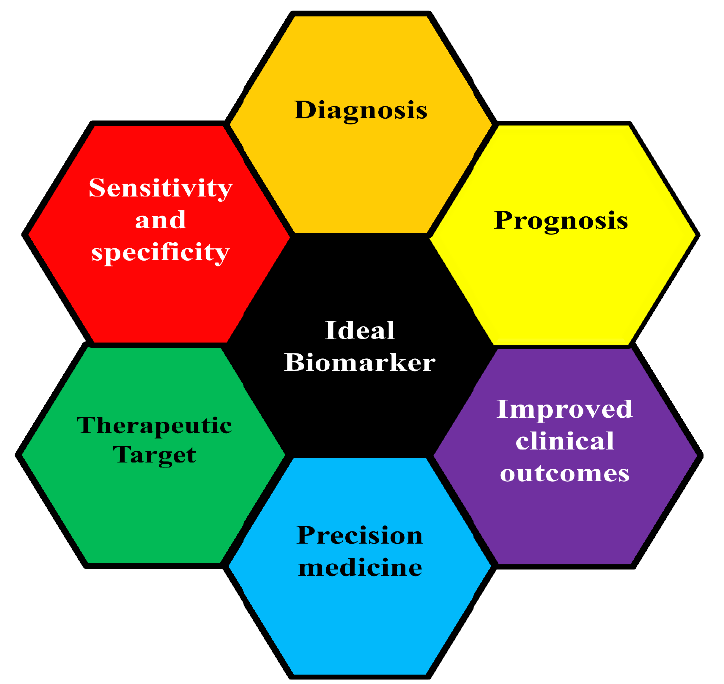
Figure 1. Ideal biomarkers are key to improved patient outcome. Biomarkers can be targeted for improved diagnosis, prognosis, and therapeutics. The identification of ideal biomarkers holds key potential to personalised medicine and overall improved clinical outcome.